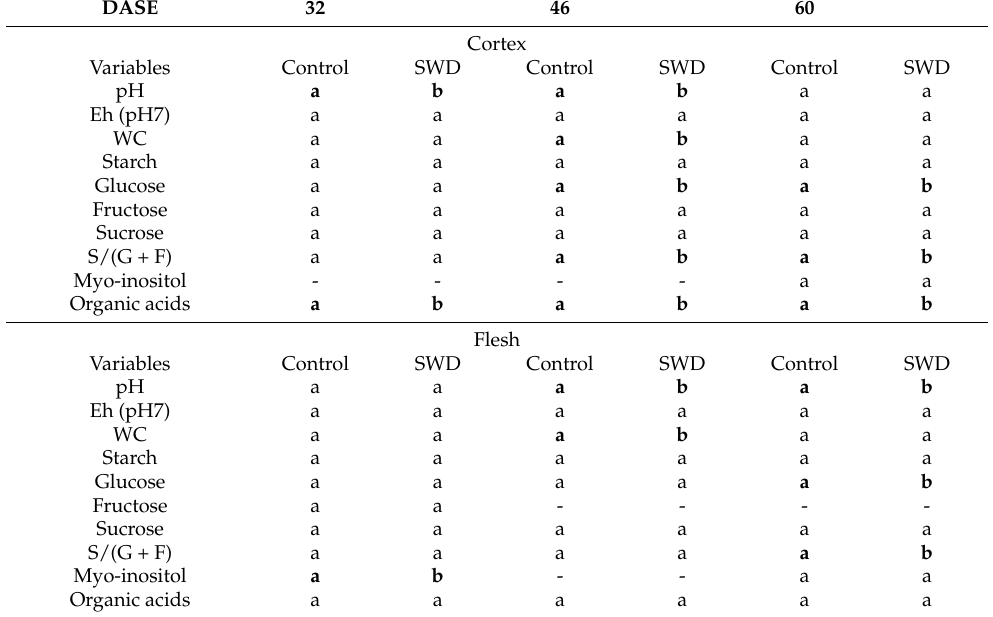
Table 2. Statistical evaluation of the effect of water regime on biochemical parameters (Student t-test or Mann–Whitney test; Statgraphics, alpha = 5%). Different letters between Control and SWD conditions for the same DASE indicate a statistically significant difference.